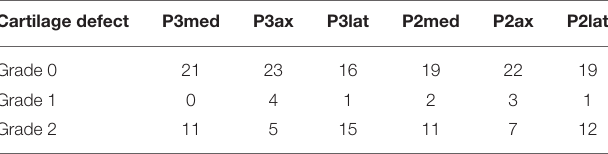
TABLE 2 | Cartilage defects in 32 limbs (20 fore limbs, 12 hind limbs) on macroscopic cartilage evaluation by